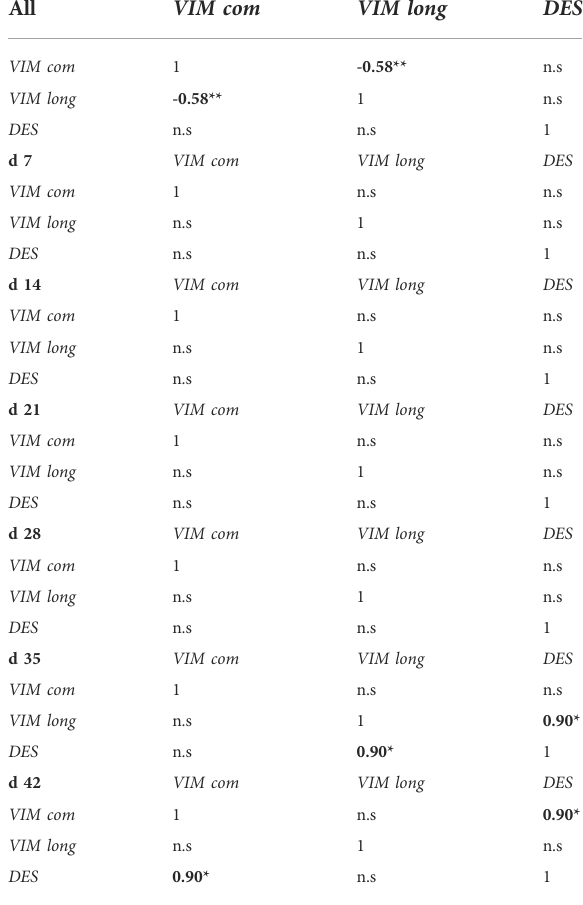
TABLE 1 One-way ANOVA results for the different developmental stages offast-growing (FG) broilers. Foreach samplingtime (d 7,d 14, d 21, d 28, d 35 and d 42), mean and standard deviation (SD) of the normalized gene expressions are reported.